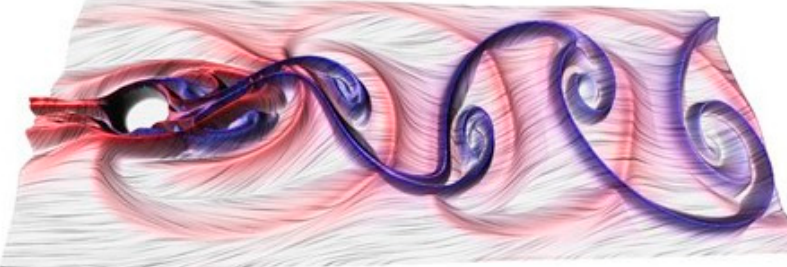
Figure 6. An example of a vortex.